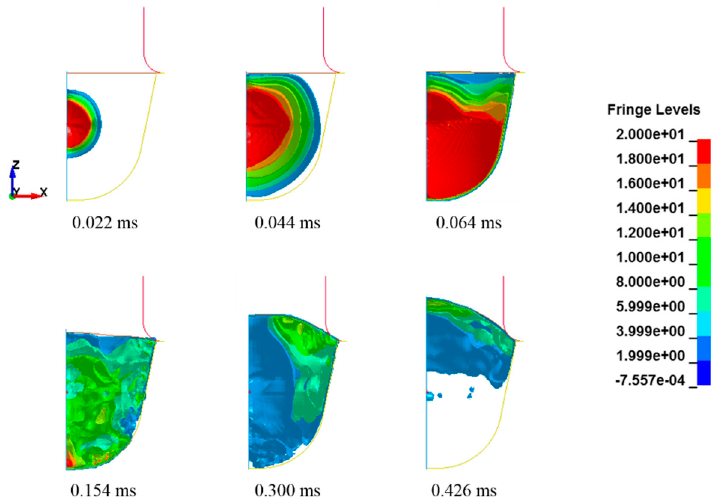
Figure 5. Pressure distribution of the fluid parts in the numerical simulation (unit: MPa).